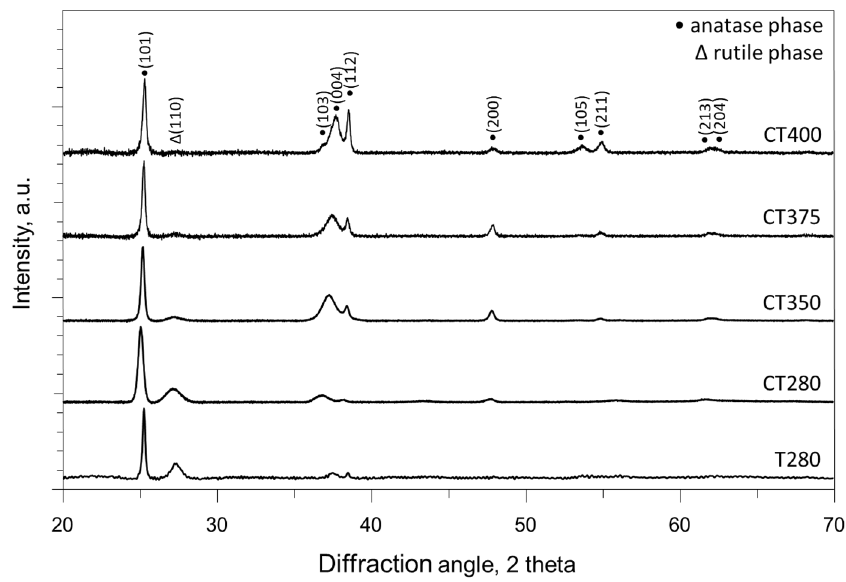
Figure 1. XRD patterns of TiO 2 and C-TiO 2 films deposited using different pulsed-DC magnetron power levels. Planes of TiO 2 anatase and TiO 2 rutile phases were indexed according to the JCPDS database cards No. 21-1272 and 21-1276, respectively.